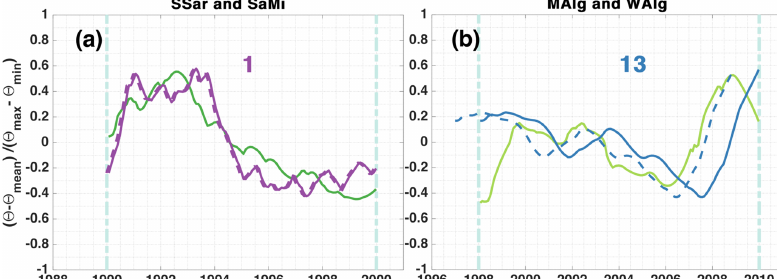
Figure 11. Cross-correlation of normalized potential temperature signals. (a) SSar (green) and SaMi (purple) between 1990 and 2000, (b) MAlg (light green) and WAlg (blue) between 1998 and 2010. The solid lines represent the original position of the time series. The dashed line represent the time series with a lag that give the maximum correlation. The lag, in months, is written above the